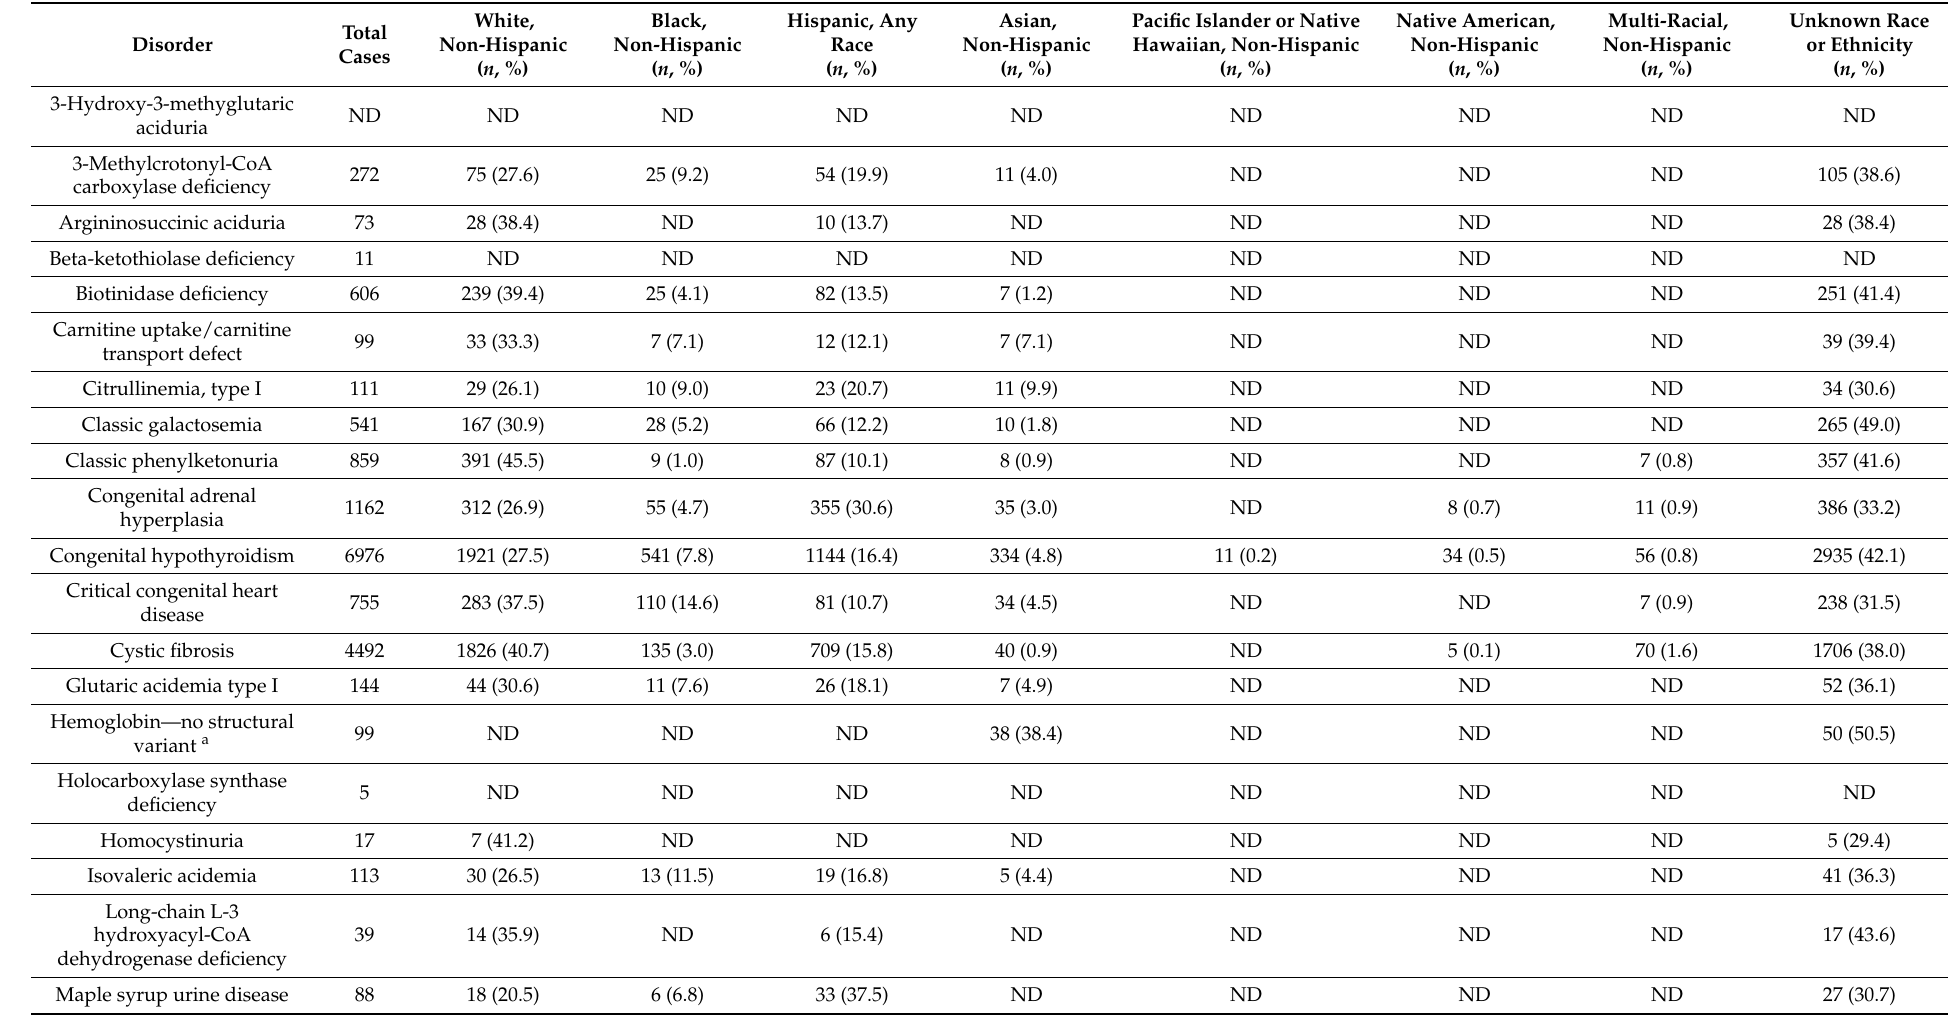
Table 2. Racial and ethnic distribution of patients with newborn screening disorders from 45 states ( n = 24,129